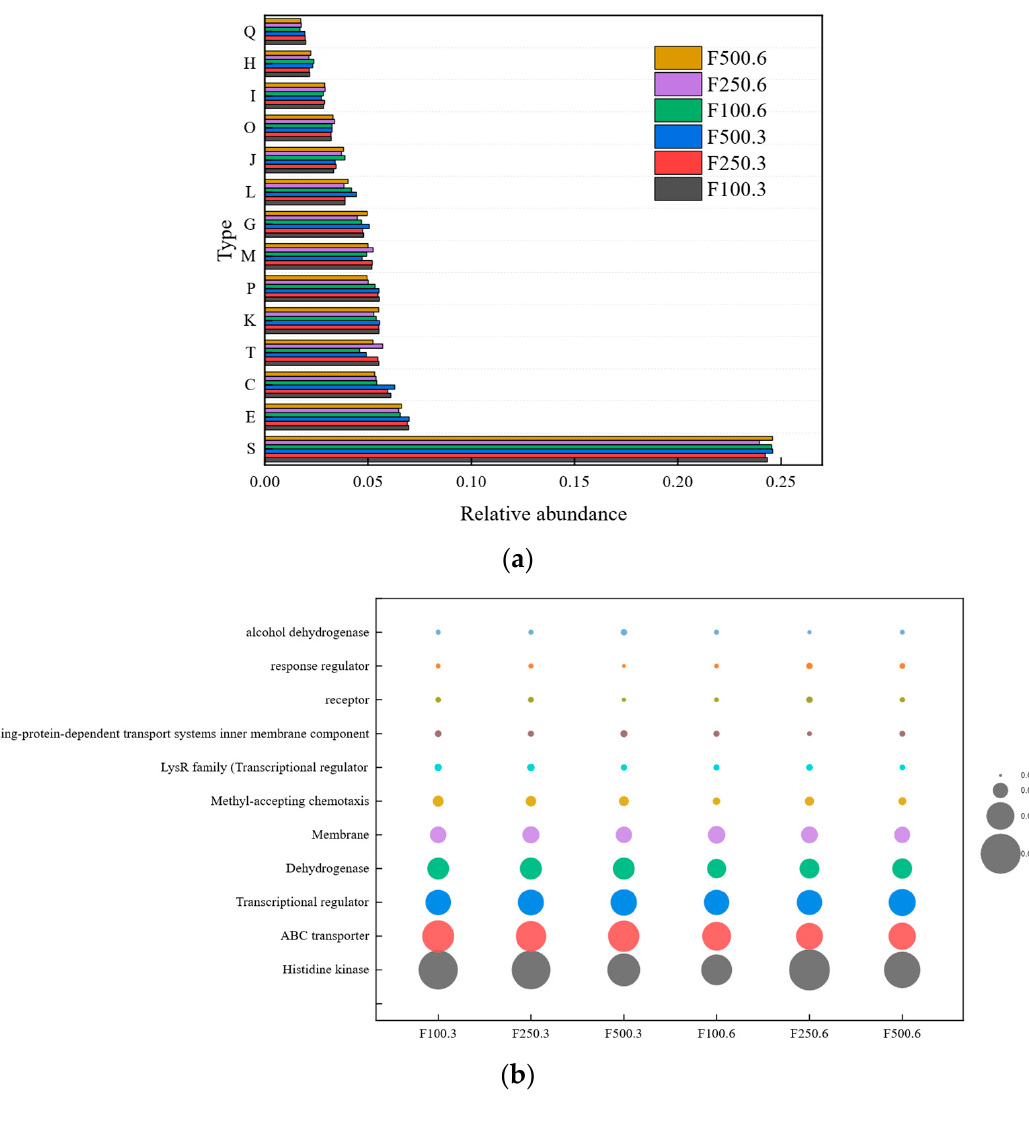
Figure 2. The relative abundance of eggNOG at level 1 ( a ) and level 2 ( b ).